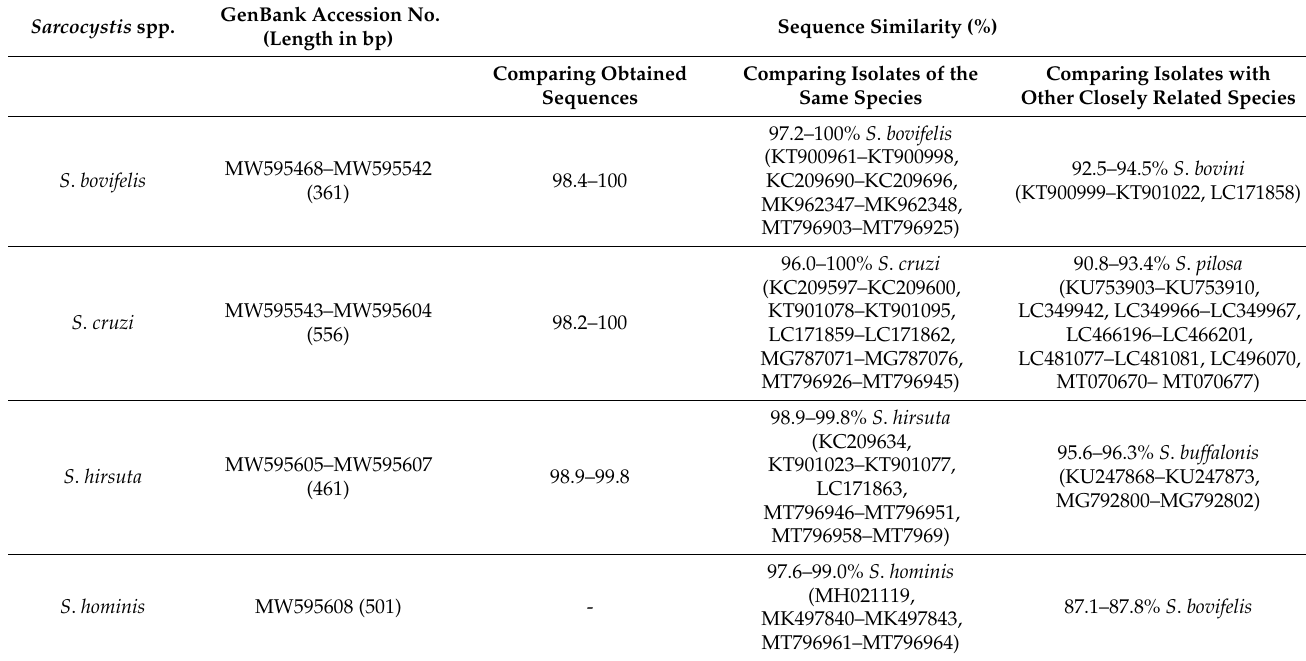
Table 3. Intra- and inter-specific genetic variability of identified Sarcocystis